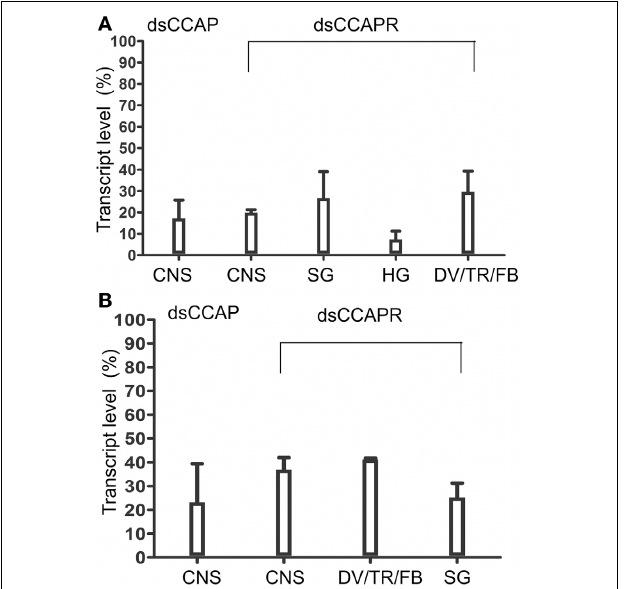
FIGURE 4 | Verification of dsRNA efficiency by real time qPCR. (A) RhoprCCAP or RhoprCCAPR expression levels were reduced in 4th instar central nervous system (CNS), salivary gland (SG), hindgut (HG) and pools of tissues including dorsal vessel/trachea/fat body (DV/TR/FB) following injection of dsCCAP or dsCCAPR, relative to control dsARG injection. (B) RhoprCCAP and RhoprCCAP receptor expression levels were similarly reduced by injection of dsCCAP and dsCCAPR concurrently, compared with the control, dsARG. Values are expressed as the mean ± s.e.m. ( n = 4).